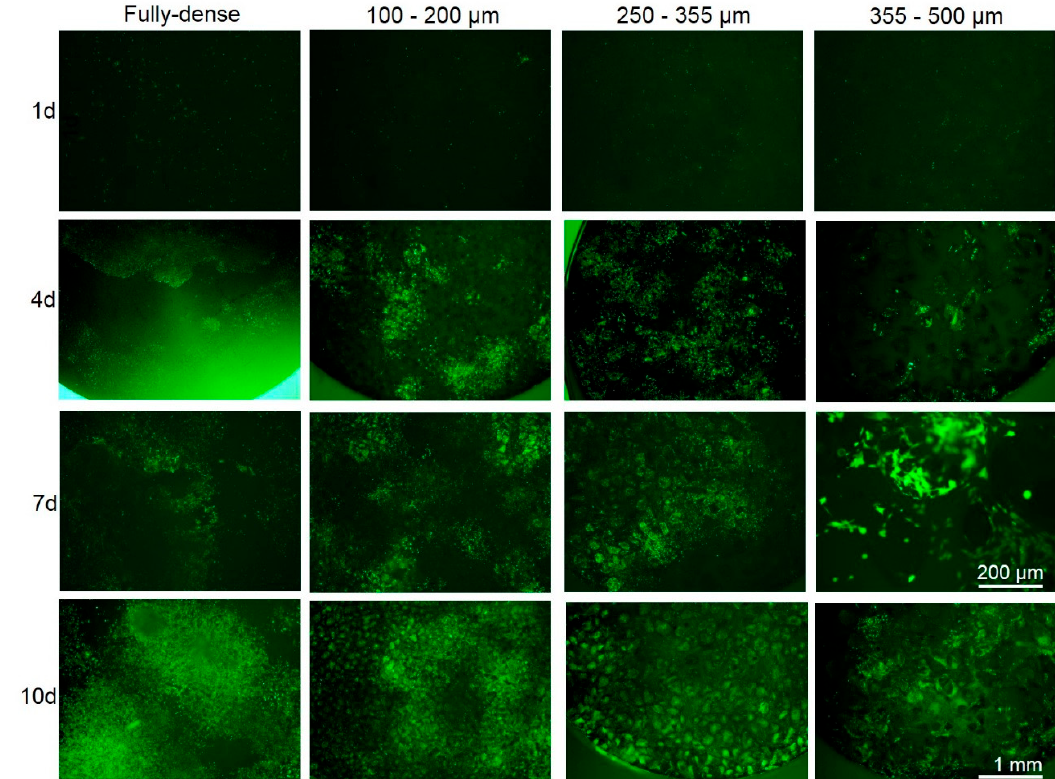
Figure 6. Inverted fluorescence microphotographs of cell adhesion and proliferation of C2C12-GFP cells after 1, 4, 7, and 10 days of cell culture. Common scale bar, 1mm, except for 7 days and pore size 355–500 μ m, which a specific scale bar is indicated (200 μ m).